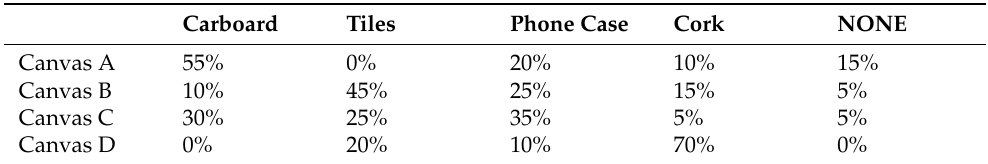
Table 2. Percentage of correct correspondence between virtual and physical textures for test 1 according to volunteers.